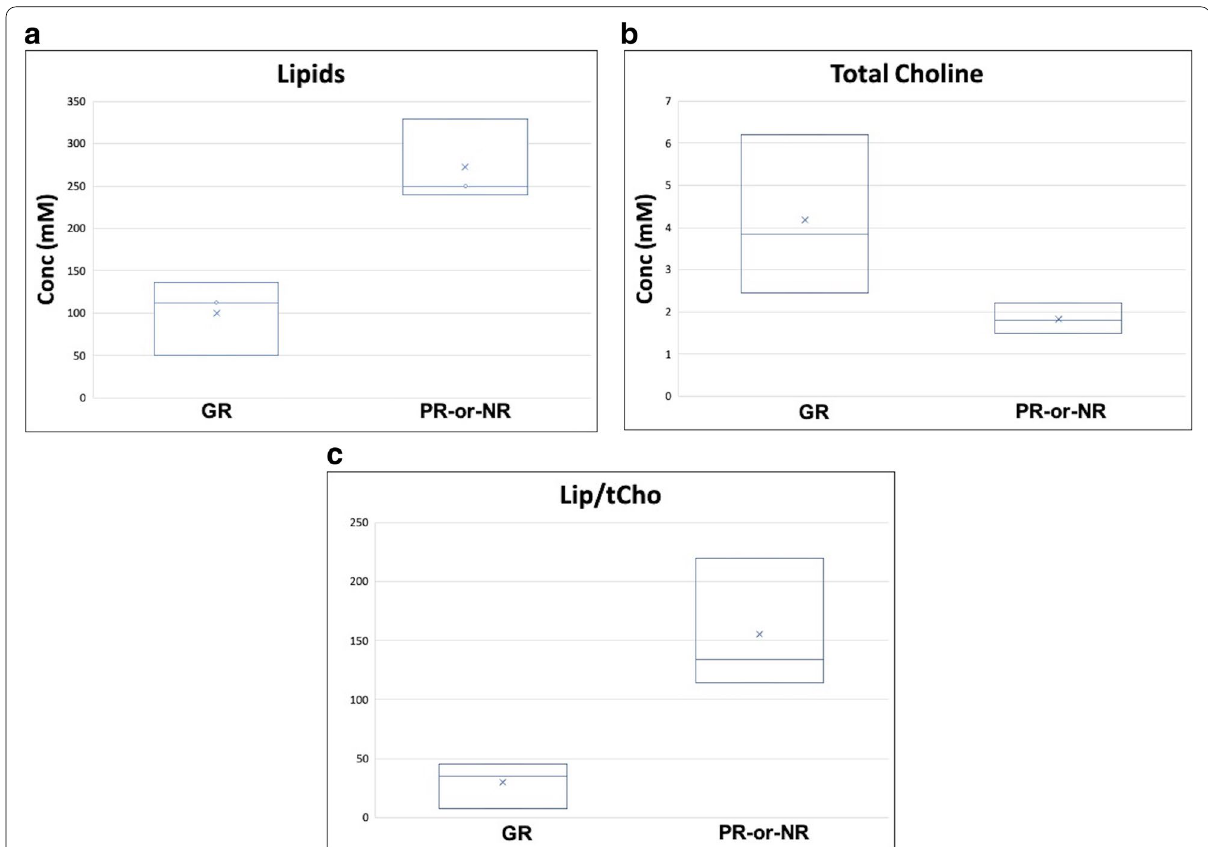
Fig. 2 Boxplot of lipid signal, resonating at 1.3 ppm ( a ) total choline (tCho) signal ( b ) and lipids/tCho (Lip/tCho) ratio ( c ) in the two groups: good responder patients (GR) on the left and partial or nonresponder patients (PR-or-NR) on the right